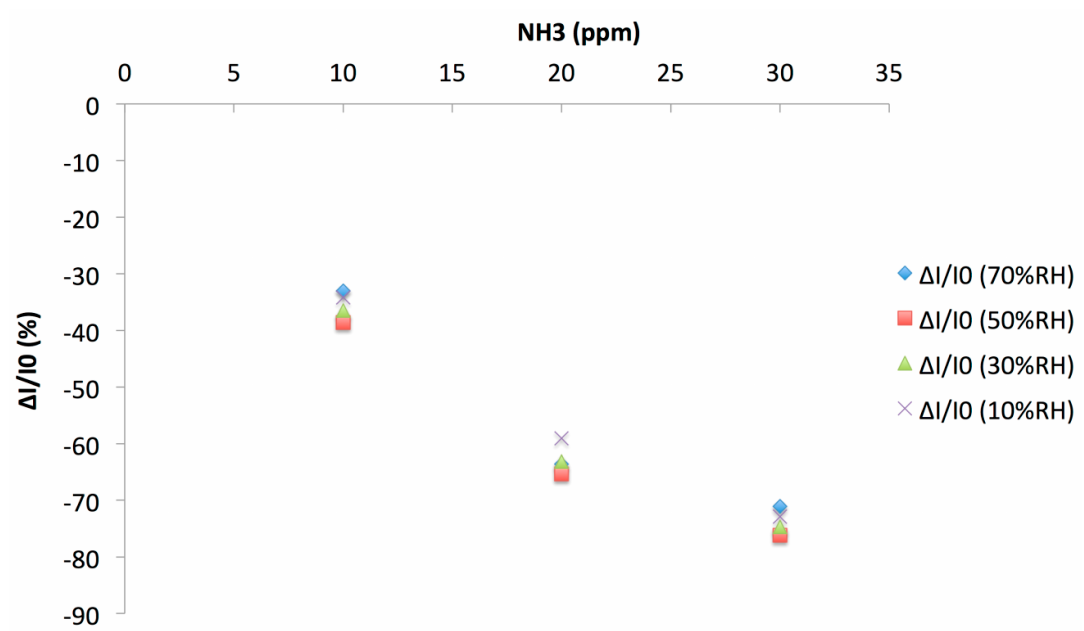
Figure 12. Relative response (ΔI/I NH concentration at various RH values, as calculated from four 0.25 min/1 min 3 exposure/recovery